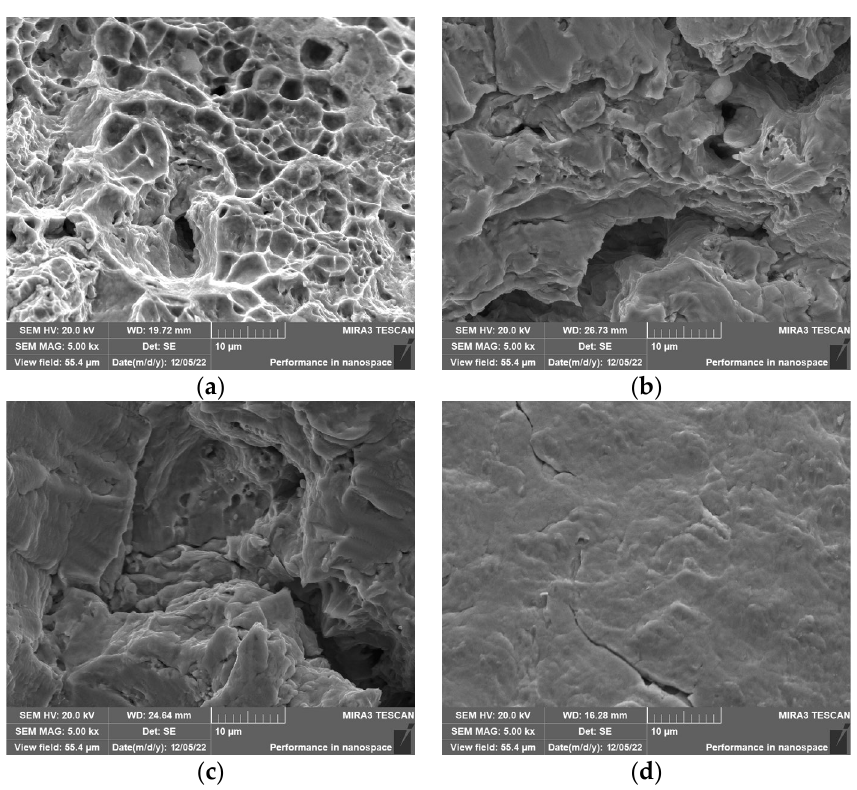
Figure 7. Center morphology of Q235 carbon steel fatigue fractures in different environments: ( a ) air; ( b ) 2wt% NaCl solution; ( c ) 5wt% NaCl solution; ( d ) 8wt% NaCl solution.